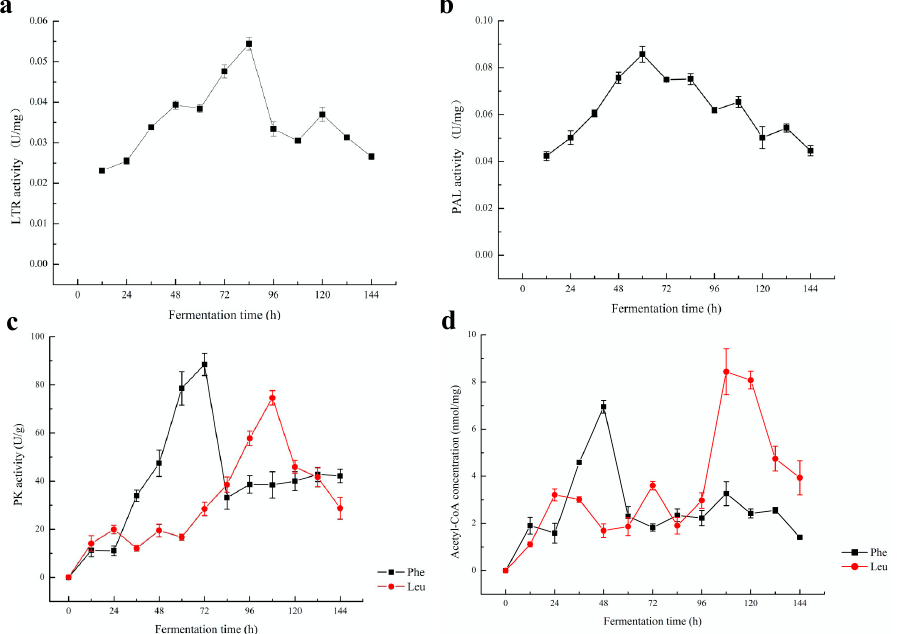
Figure 3. Changes in the activities of key enzymes in the simulated juice systems with the addition of different amino acids during fermentation. ( a ) LTR in the leucine-added simulated juice system; ( b ) PAL in the phenylalanine-added simulated juice system; ( c ) PK; ( d ) acetyl-CoA.